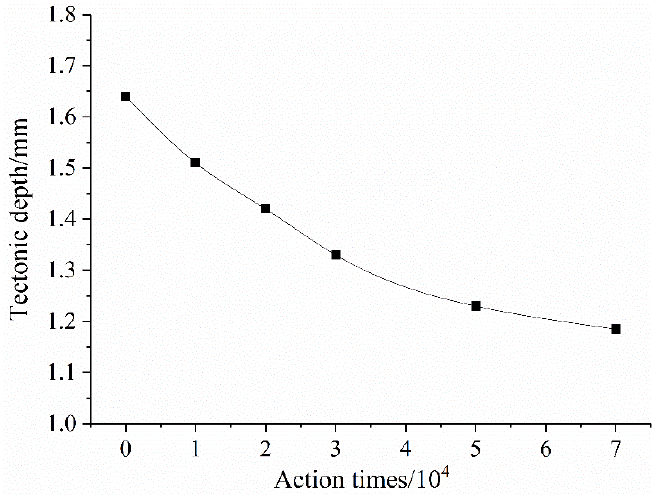
Figure 12. OGFC structural depth change curve.